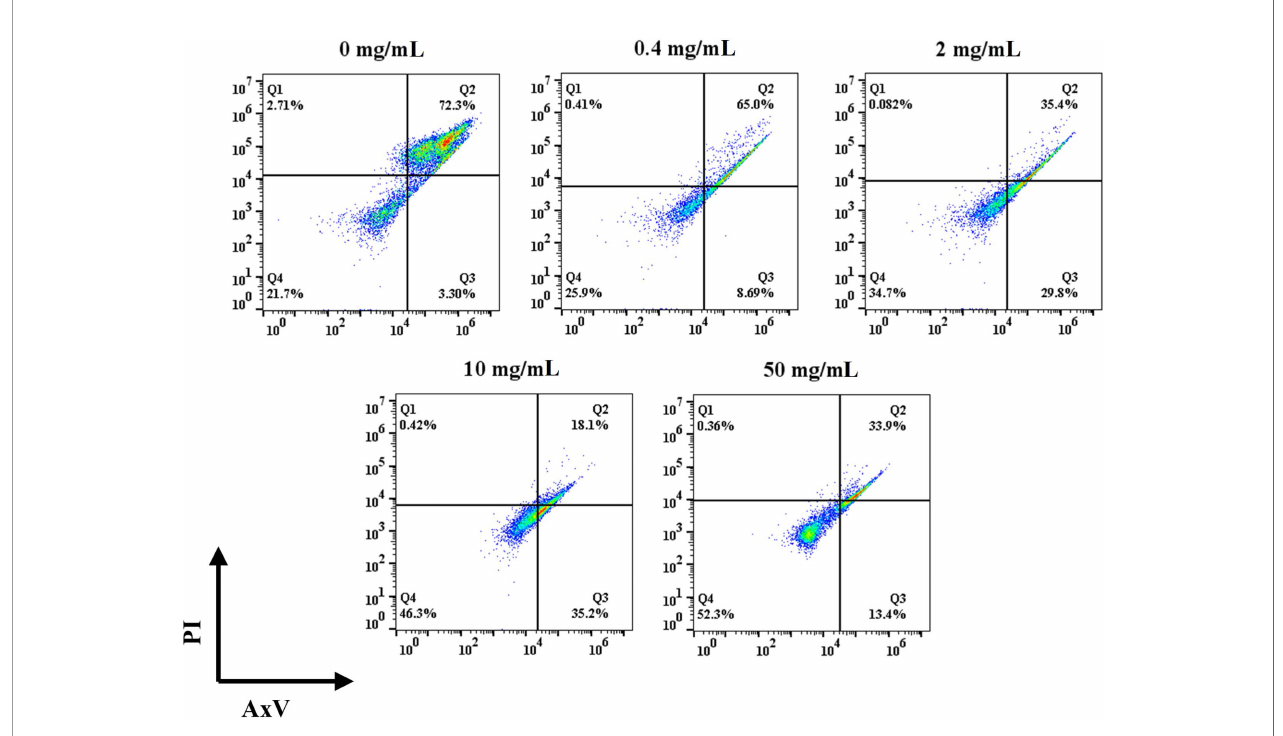
FIGURE 3 | Effect of HFD on the viability of mouse primary T